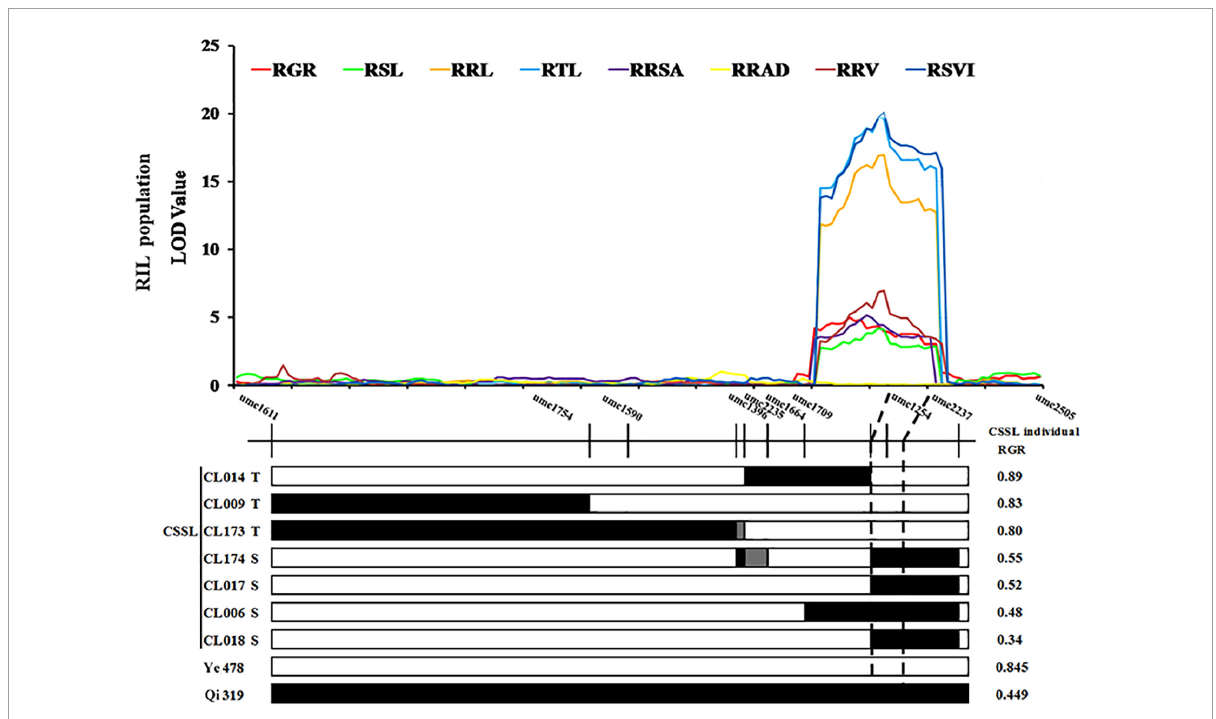
FIGURE4 cQTL1-2 fine mapping in CSSL lines. White represents the homozygous segment of Ye478, black is the homozygous segment of Qi319, gray is the hybrid segment. T- material of tolerant line, S- material of sensitive line. For each trait, different colors of LOD value represent the eight different traits related to low-temperature tolerance (RGR, RSL, RRL, RTL, RRSA, RRAD, RRV, and RSVI) of the RIL